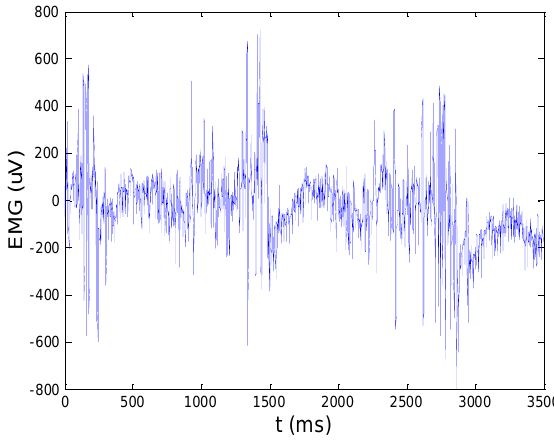
Figure 13. Raw EMG signal recorded on tibialis anterior muscle.